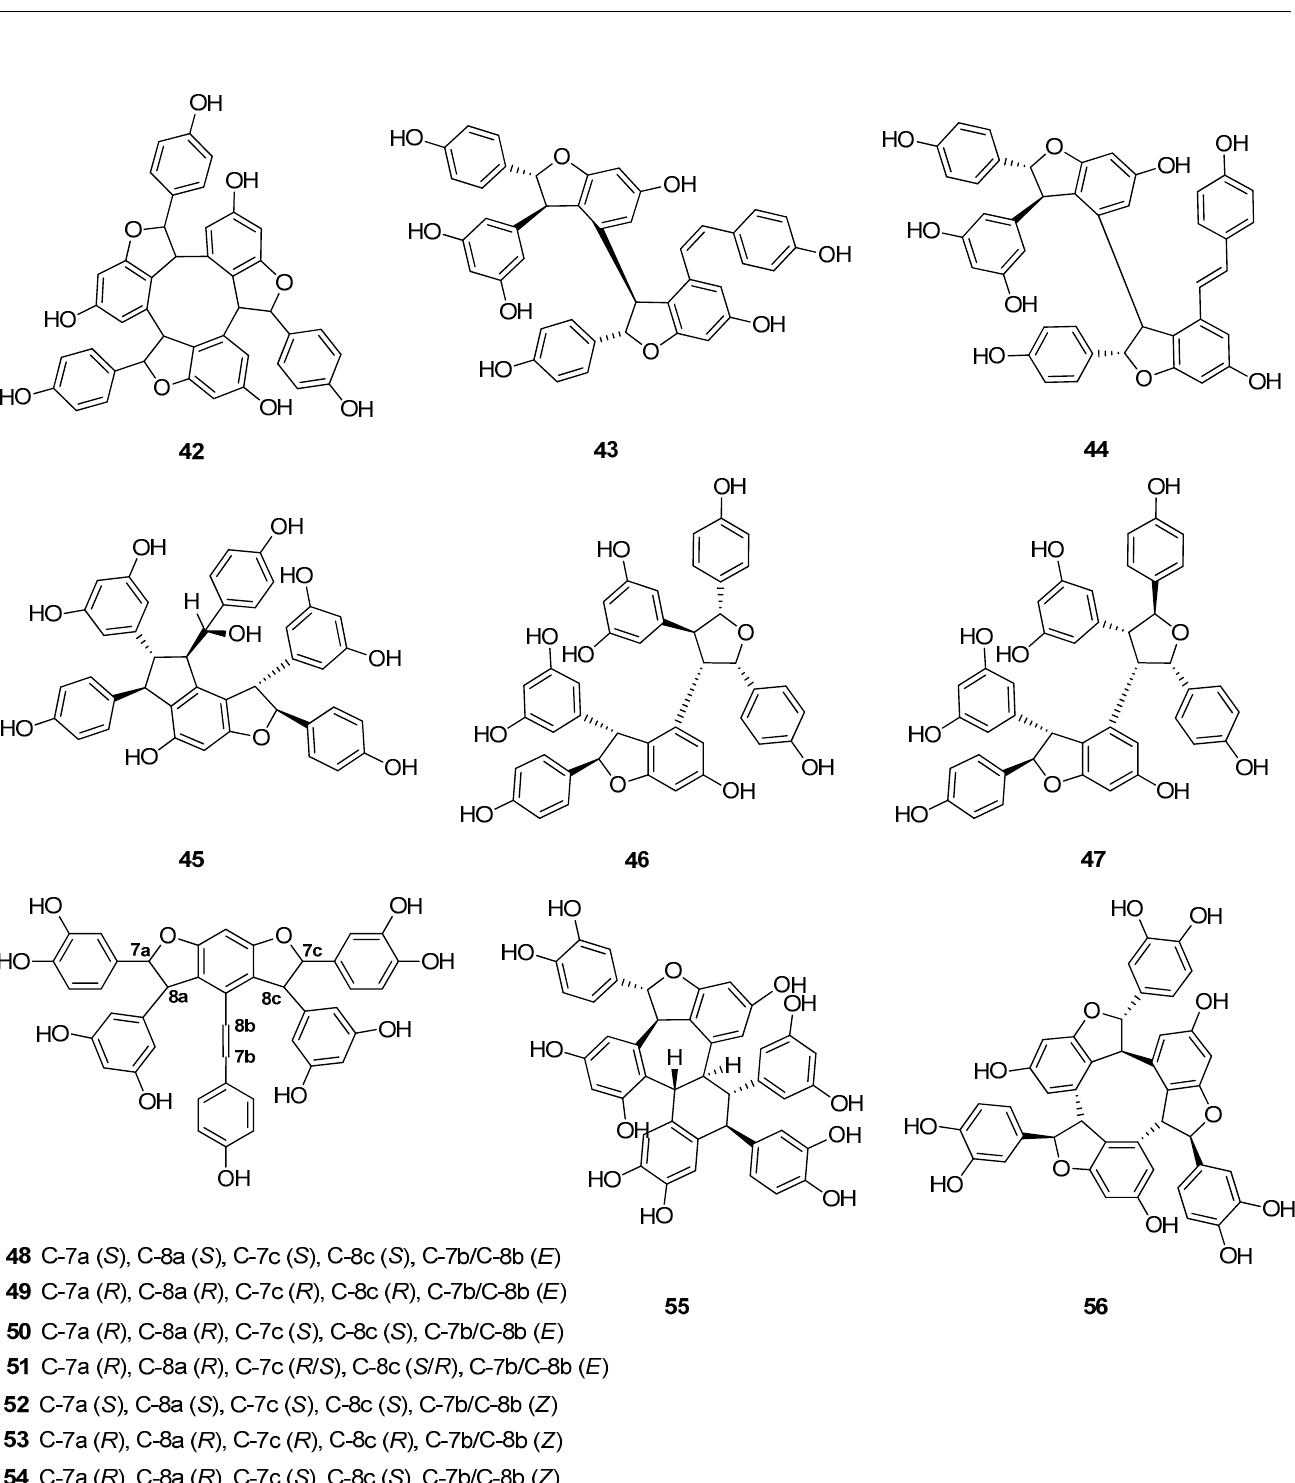
Figure 5. Stilbenoid trimers isolated from Cyperaceae species .